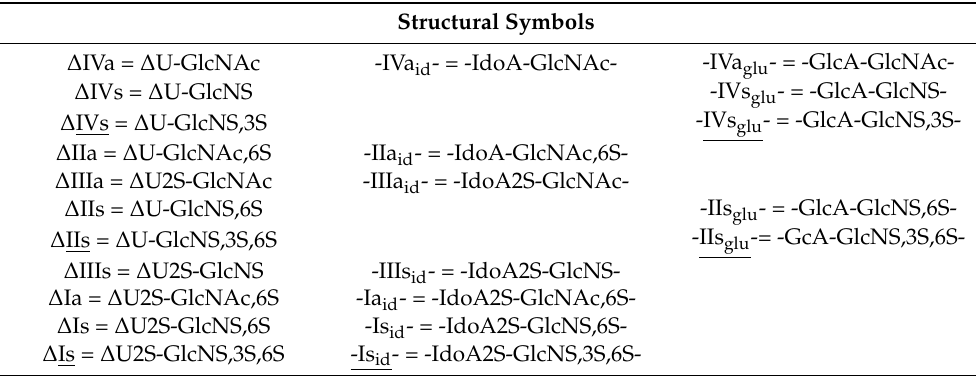
Table 1. Structural